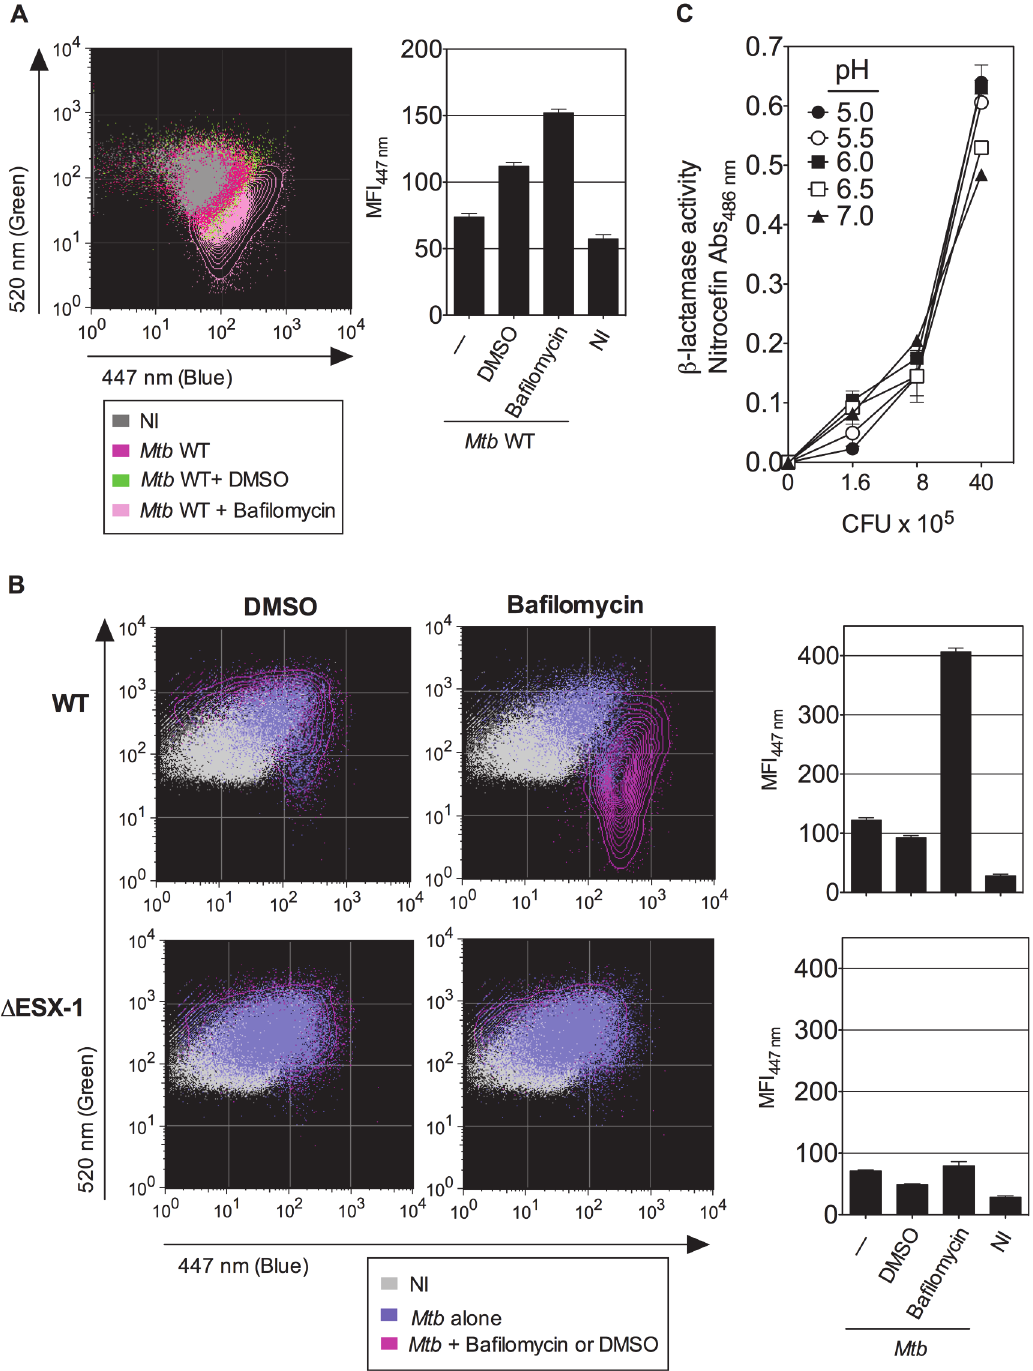
Fig 5. Inhibition of phagosomal acidification intensifies phagosomal rupture in Mtb -infected phagocytes. (A-B) Raw264.7:: nramp-1R cells (A) or BM- DC from Sv129 nramp-1R mice (B) were treated with 20 nM of bafilomycin or DMSO 1h before infection with WT or Δ ESX-1 Mtb (MOI = 1) and were assessed for phagosomal rupture at 4 dpi. (C) The intrinsic β -lactamase activity of WT Mtb , grown in Dubos broth with various pH, as measured by nitocephin, a chromogenic β -lactamase substrate. The results are representative of 2